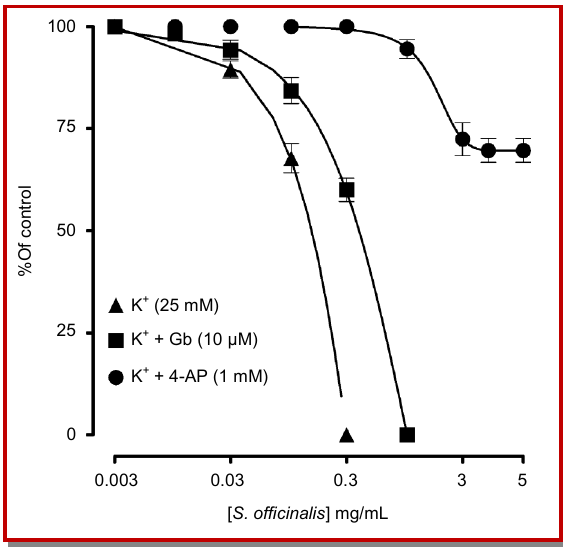
Figure 3: Inhibitory effect of the crude extract of S. officinalis , against low K + -induced contractions in the absence and pres- ence of glibenclamide (Gb), and 4-aminopyridine (4-AP) in isolated rabbit jejunum preparations. Symbols represent mean ± SEM; n =